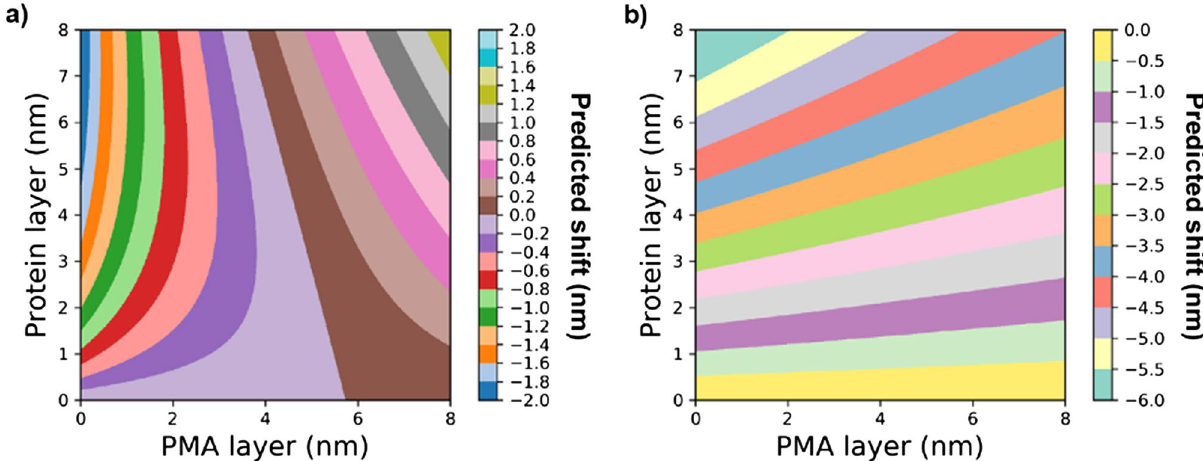
Figure 4. Predicted shift according to the core–shell model for different combinations PMA and corona thicknesses. ( a ) 5 nm and ( b ) 50 nm NP. Each coloured area corresponds to a predicted range of the